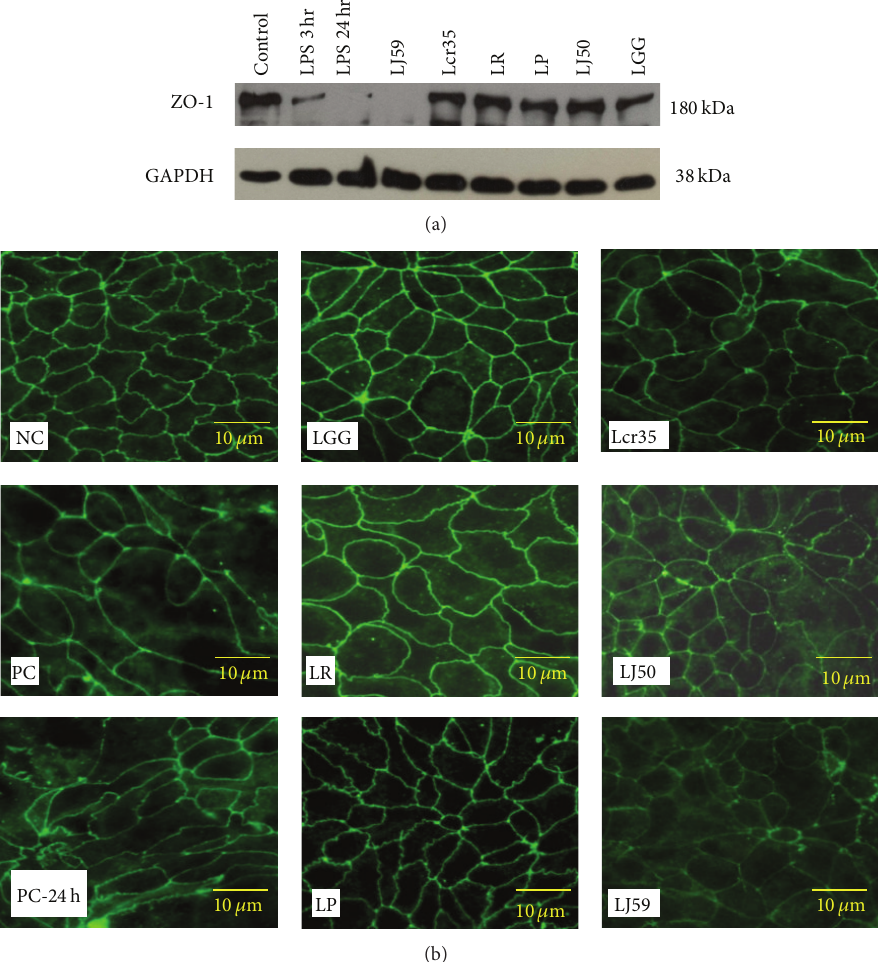
Figure 2: The appearances of tight junctions were evinced by immunostaining ZO-1 expression and localization after LPS and Lactobacillus administration. Negative control (NC) without treatment and positive control (PC) exposed to LPS for 3 hr were shown. Inflamed Caco-2 cells were colonized without bacteria (PC-24h) or with LGG, LR, LP, Lcr35, LJ50, or LJ59 for 24 hr. (a) Representative 180-kDa ZO-1 band was shown by Western blot analyses. Expression of ZO-1 showed significantly lower levels in the PC and PC-24h groups when compared to the NC group. (b) Representative slides were evaluated by immunofluorescence microscopy. Expression of ZO-1 showed similar levels in the LR, LP, and LGG groups when compared to the NC group. GAPDH: glyceraldehyde 3-phosphate